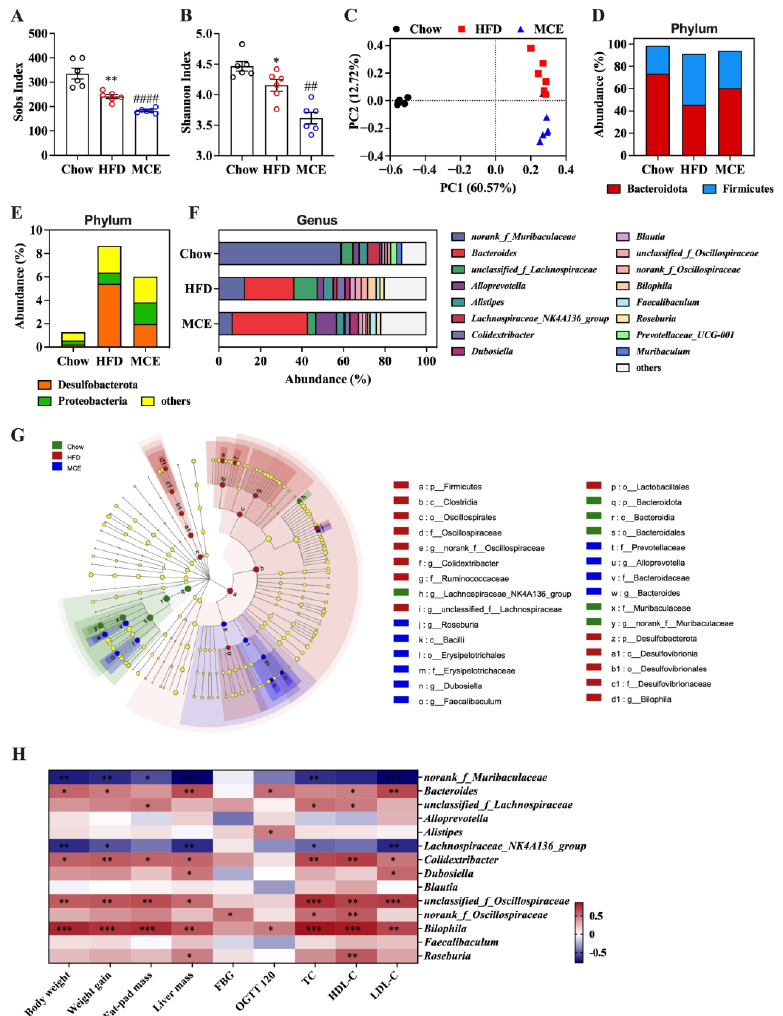
Figure 4. MCE supplementation modulates the gut microbiota in HFD-fed mice. The α -diversity is represented by the ( A ) Sobs index and ( B ) Shannon index. * p < 0.05 versus chow group, ** p < 0.01 versus chow group; ## p < 0.01 versus HFD group, #### p < 0.0001 versus HFD group. ( C ) The principal coordinate analysis (PCoA) based on Bray-Curtis distance. The relative abundance of gut microbiota at ( D ), ( E ) phylum level and ( F ) genus level. ( G ) The linear discriminant analysis effect size (LEfSe) analysis. ( H ) Pearson correlation analysis between obesity-related indexes and relative abundance of gut microbiota at genus level. The blue color represents a negative correlation, while the red color represents a positive correlation. The color depth is proportional to the degree of the correlation. * p < 0.05, ** p < 0.01, *** p <